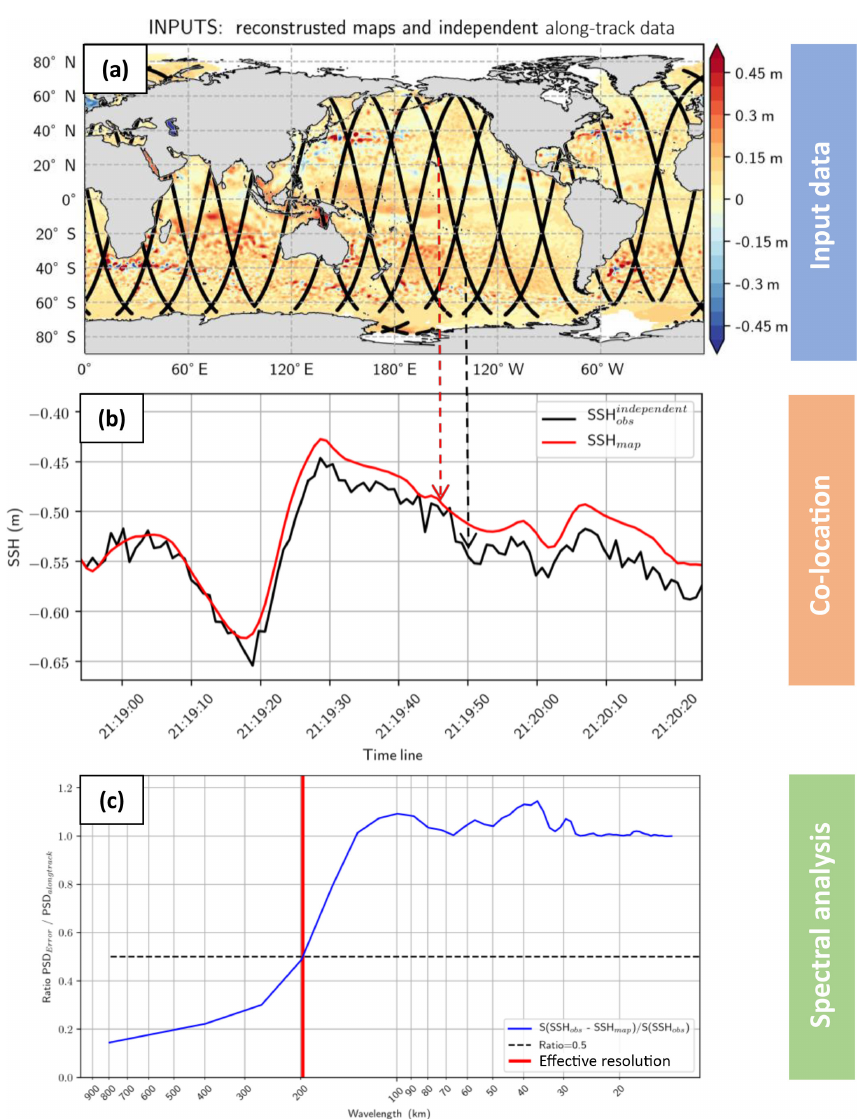
Figure 1. Schematic illustration of the methodology: (a) input data selection, (b) co-location of SLA and gridded SLA and (c) spectral analysis showing the ratio error spectrum to signal